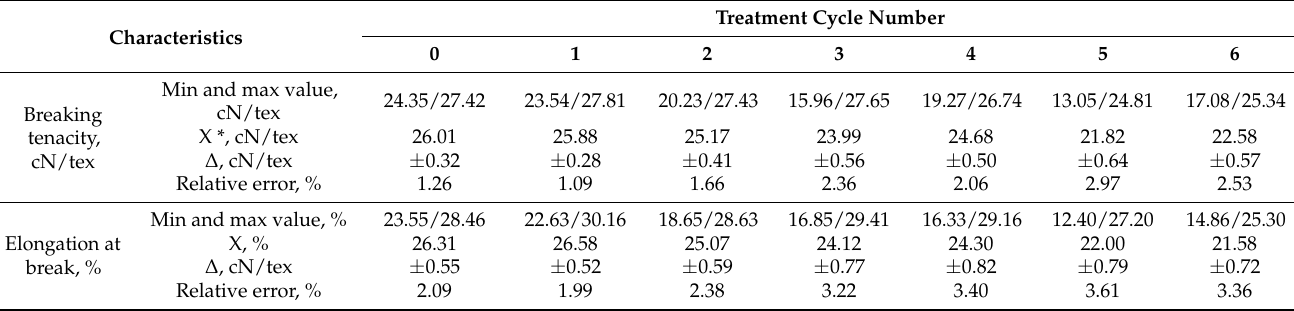
Table 4. Tensile characteristics of investigated PES